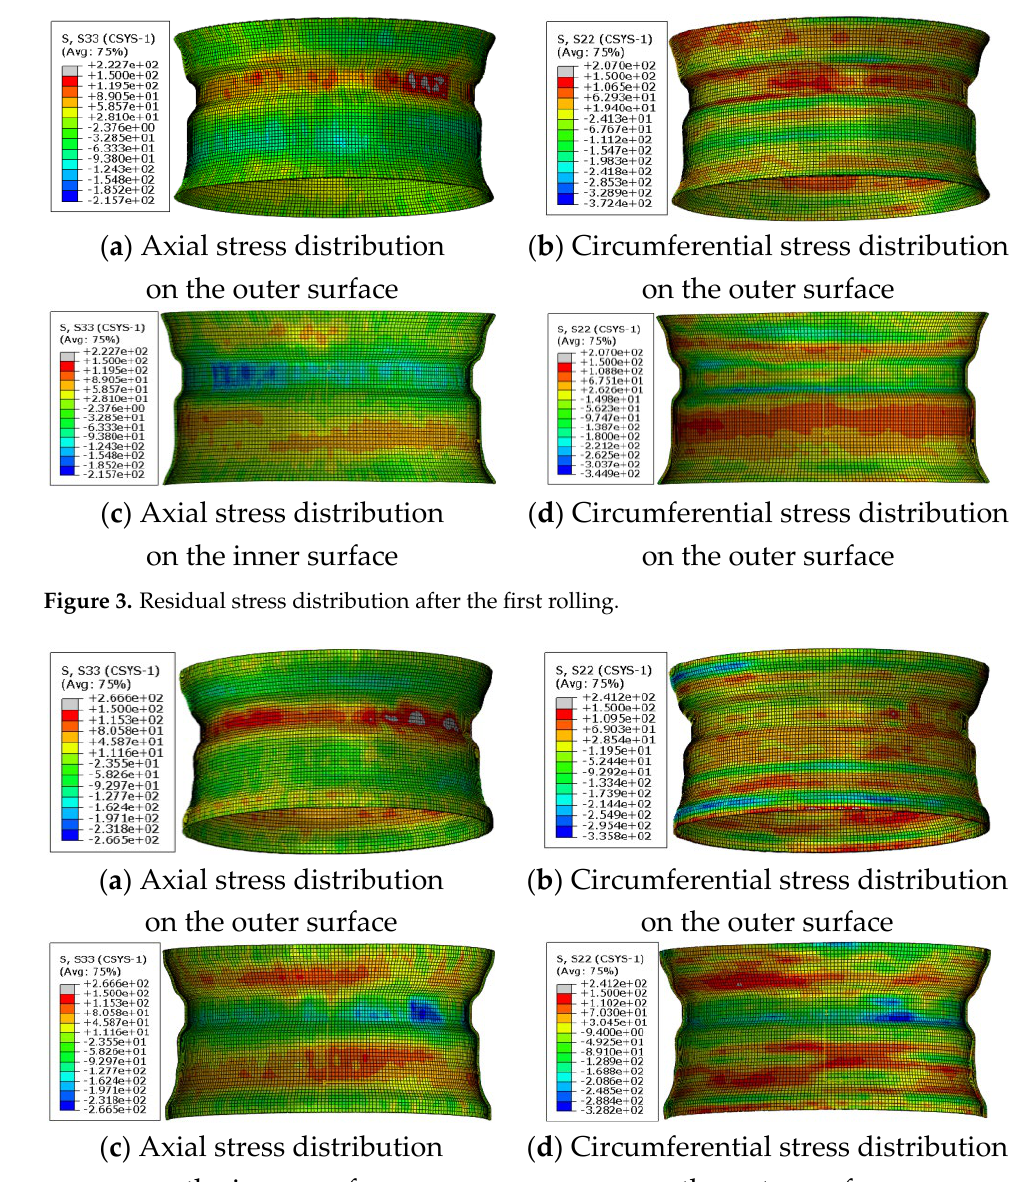
Figure 4. Residual stress distribution after the second rolling. As the shape of the rim is already relatively close to the workpiece in the first two roll forms, the third roll is mainly for forming the outer edge and the rib in the middle of the rim to achieve precise forming, and the residual stress distribution after rolling is shown in Figure 5. The arc radius of the wheel rim is small, and the material here undergoes serious plastic deformation during the forming process, so the residual tensile stresses of high magnitude appear on the outer surface of this area. It can be seen that the residual tensile stresses are on the outer surface of the groove bottom, there are large residual tensile stresses on the outer surface and inner surface of the outer edge, and the maximum value is 274.9 MPa. It will have a certain negative effect on the fatigue life of the steel wheel. The rim-roll-forming simulation simulates the actual rim-forming process. When the lower roll drives the rim blanks to rotate upward, the rim will inevitably have a large impact in the local area, and its regional residual stress will show a certain asymmetry in the